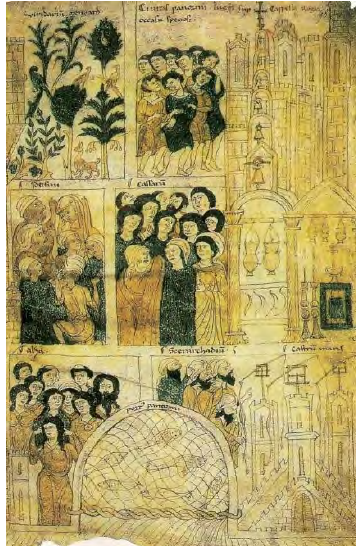
Figure 2. Funerals of William II. Neighborhoods of the ancient Palermo during Normans. Liberad Honorem Augusti di Pietro da Eboli, Berna Biblioteca